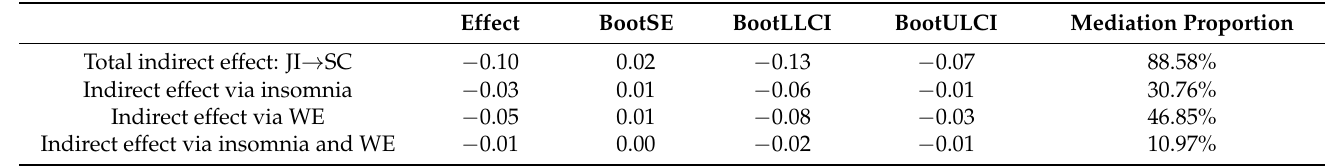
Table 4. Indirect effects of job insecurity on safety compliance based on 5000 bias-corrected bootstrapped samples.